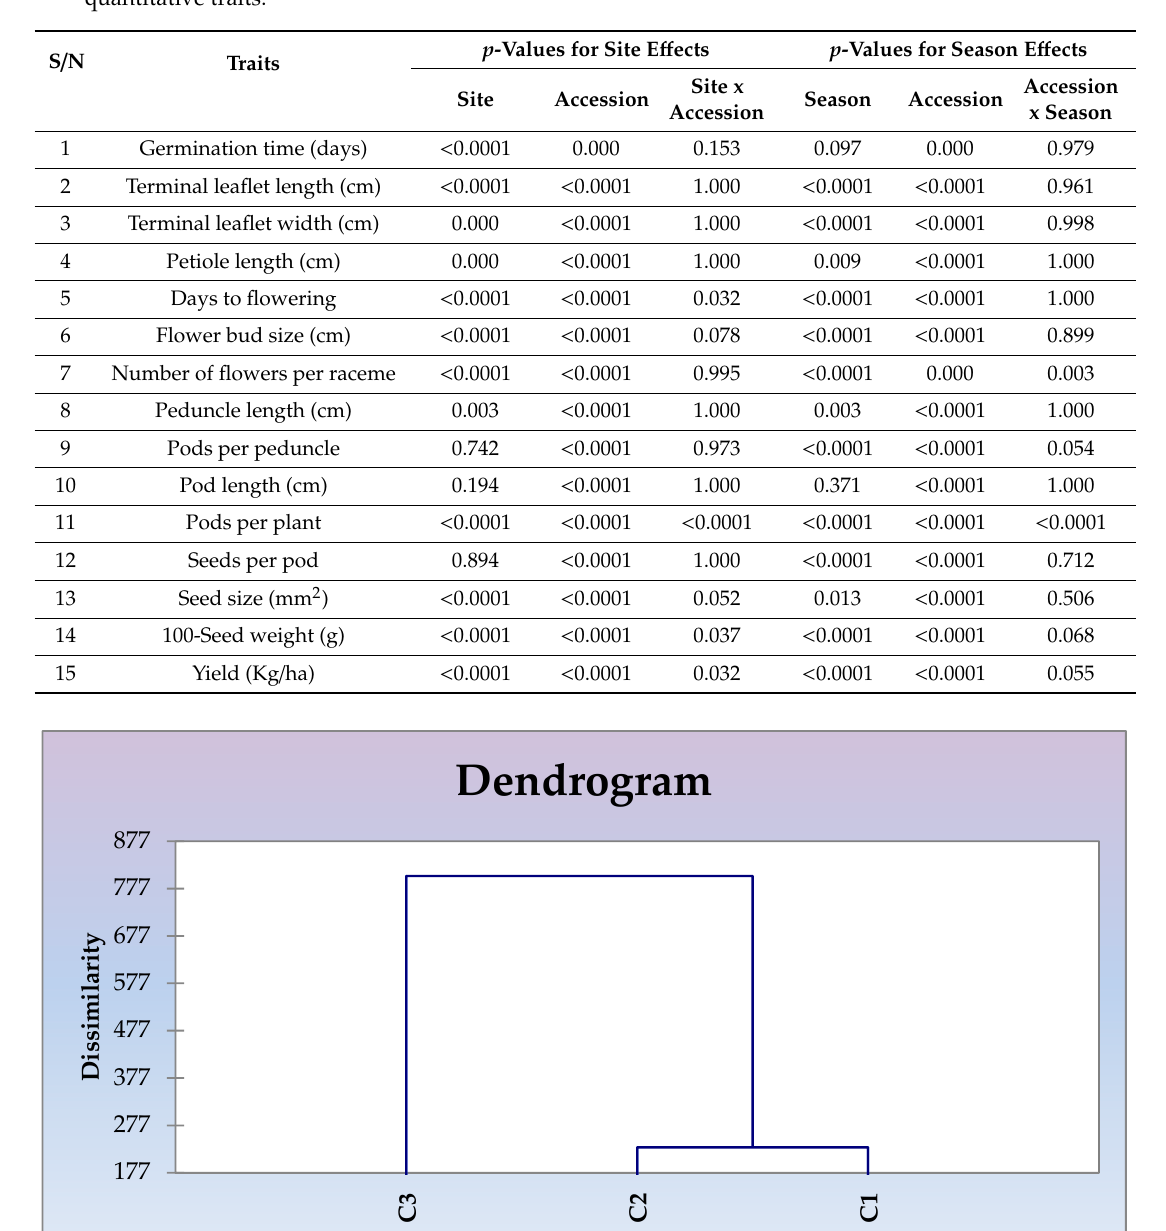
Table 5. Two-way analysis of variance for the interactions due to the site and season for the studied quantitative traits.